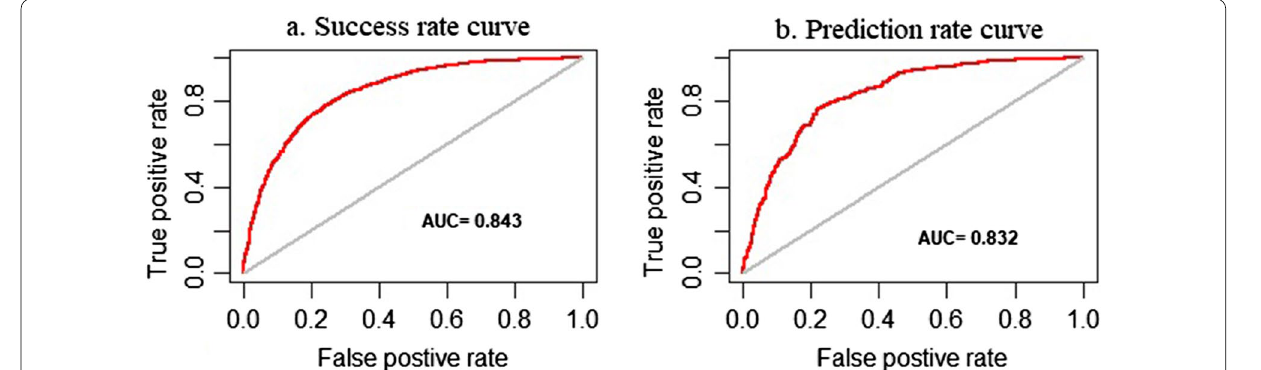
Fig. 7 Success rate ( a ) and prediction rate ( b ) curves with AUC values